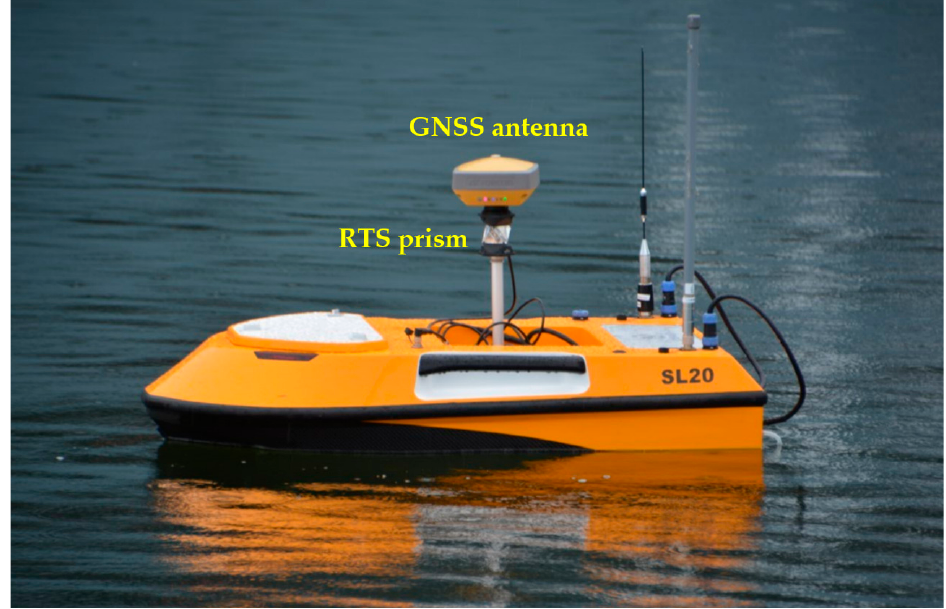
5 of 19 Figure 2. Survey lines in the area od study. 2.3. Equipment: USV and GNSS Receiver Bathymetric surveys are carried out using a twin-engine USV OceanAlpha USV SL20 (OceanAlpha Group Ltd., Hong Kong, China) equipped with a single beam echosounder and an internal GPS receiver (Figure 3). In order to provide high accuracy of position co-